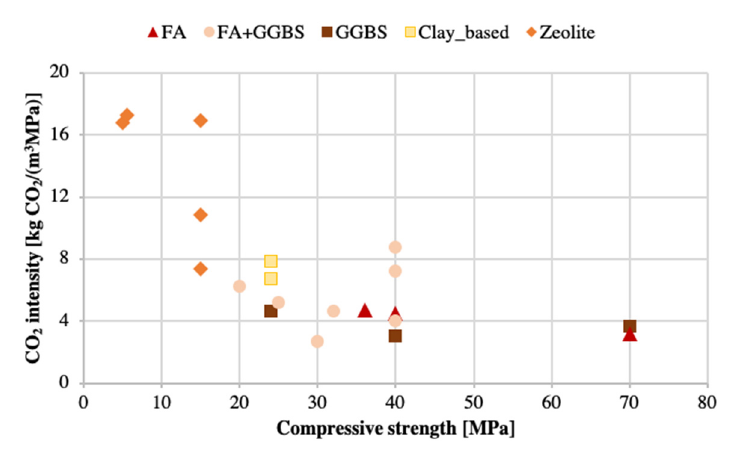
Fig. 4. CO 2 intensity as a function of compressive strength for AA binders distinguishing the precursors used. Data from published LCA literature [13 ‐